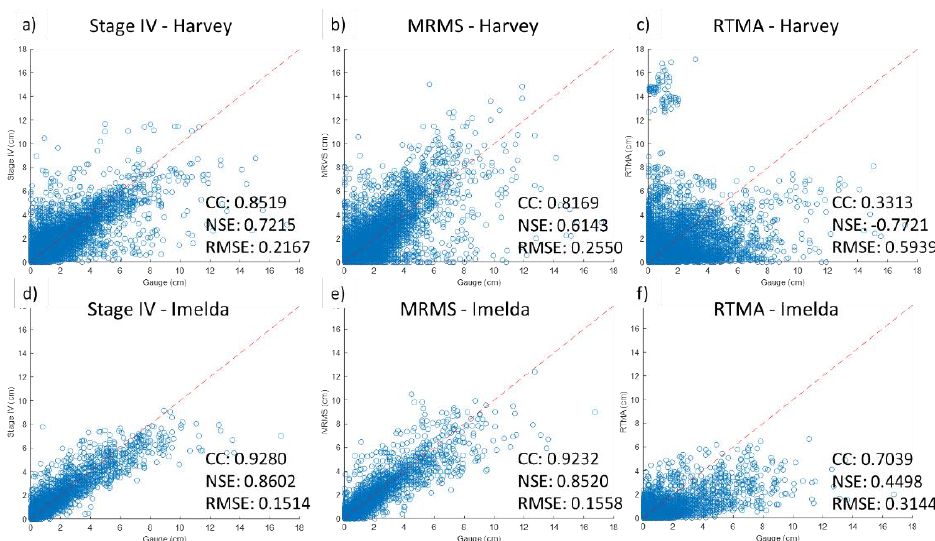
Figure 5. Scatterplots of original radar data and calibration gauge data from ( a ) Stage IV of Hurricane Harvey, ( b ) MRMS of Hurricane Harvey, ( c ) RTMA of Hurricane Harvey, and ( d ) Stage IV of Tropical Storm Imelda, ( e ) MRMS of Tropical Storm Imelda, ( f ) RTMA of Tropical Storm Imelda.